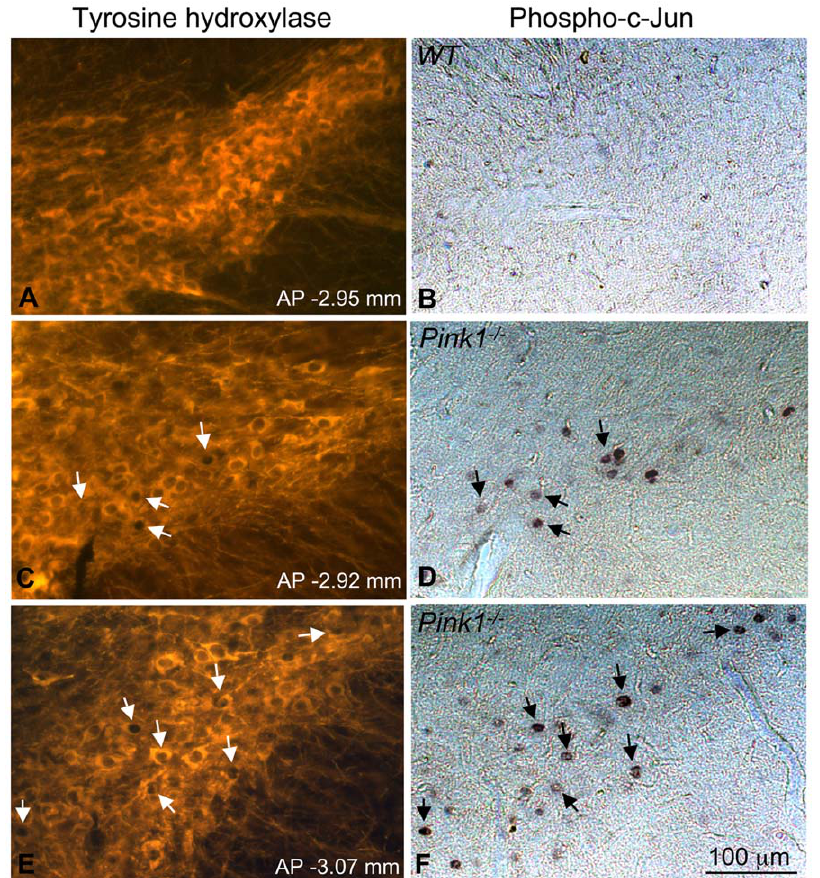
Figure 5. Accumulation of phospho-c-Jun in the substantia nigra of Pink1 2 / 2 mice. Cryosections of the substantia nigra from wildtype (A– B) and Pink1 2 / 2 mice (C–F) were stained with antibodies against phospho-c-Jun (nickel-DAB staining) and subsequently TH (fluorescent) as described in the Methods. Arrows in panels C–F point to cells expressing nuclear phospho-c-Jun that is surrounded by TH-positive cytosol, suggesting that these cells are dopaminergic neurons. AP coordinates of sections according to the mouse stereotaxic atlas (Franklin and Paxinos, The Mouse Brain in Stereotaxic Coordinates, Third Edition 2007) are indicated to demonstrate that phospho-c-Jun was expressed in distantly spaced sections of Pink1 2 / 2 mice (C–F), including sections anatomically matched to wildtype control mice (compare A–B and C–D). All three Pink1 2 / 2 mice but none of the wildtype mice showed expression of phospho-c-Jun in a subpopulation of TH-positive neurons.